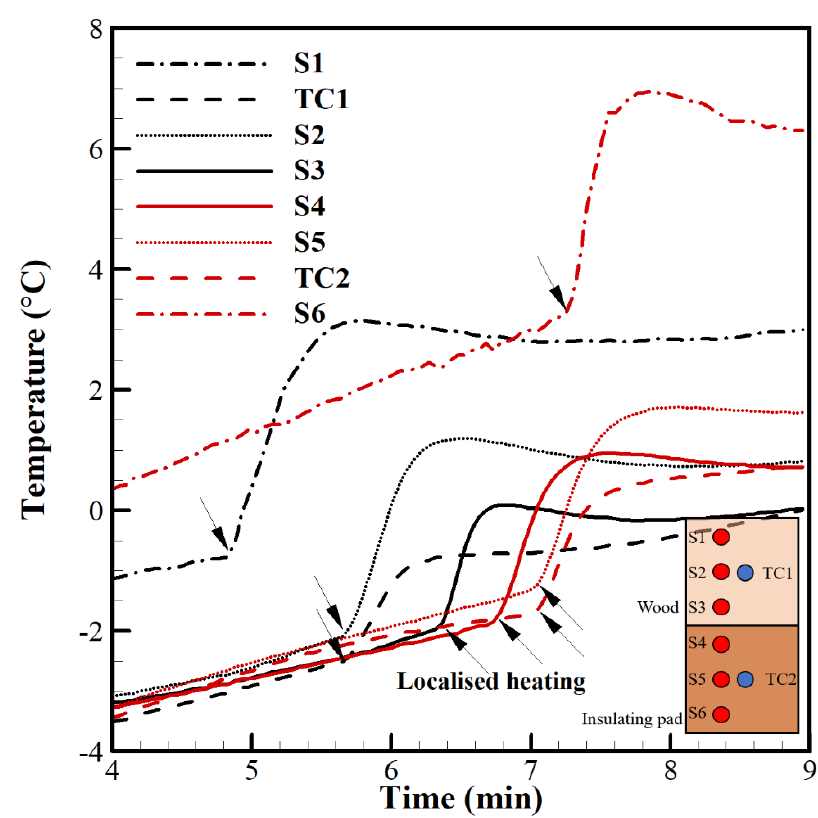
Figure 3. Bench testing of multi-junction thermocouple array demonstrating independence of SSPs temperature measurements. Arrows mark the application of localised heating.